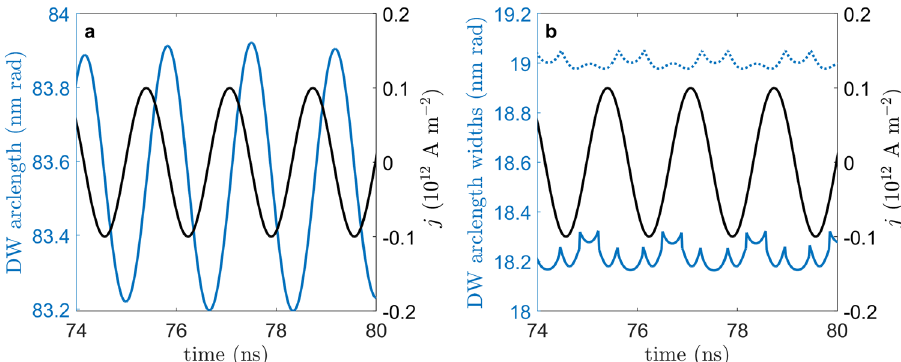
Fig. 7 Averaged magnetization for domain walls (DW). Spatially averaged domain-wall dynamics along the path T ( θ ) from micromagnetic simulations of the 2DW state subject to a microwave current density j of 1 GHz and amplitude 10 × 10 11 A m − 2 . The distance between the domain walls is shown to oscillate at the same frequency of the microwave current (black curve) in panel ( a ). The pro fi le of the domain wall is also modi fi ed but exhibiting a more complicated pattern in panel ( b ). The solid and dotted lines represent each domain wall width of the 2DW state.